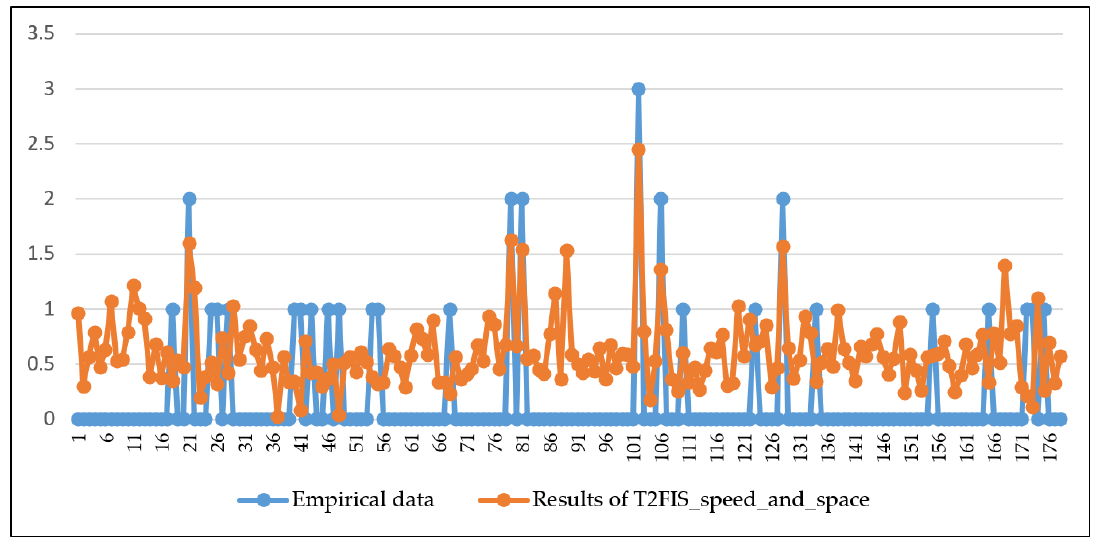
Figure 13. A comparison of empirical data and results of T2FIS in the case of speed and space capabilities assessment—T2FIS_speed_and_space. Table 5. The difference between cumulative deviation (CD) values per T2FIS tested by paired t -test.